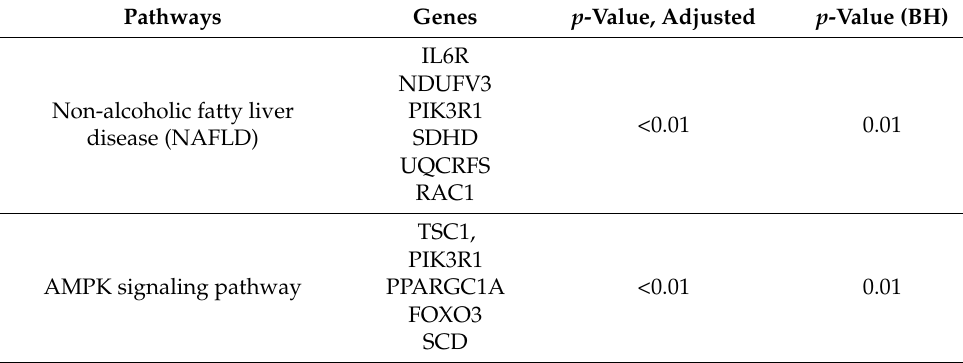
Figure 2. Evaluation of logistic regression models to compare Group 1 and Group 3. Table 6. Pathways regulated by miRNAs hsa-miR-451a, hsa-miR-23a-3p, hsa-miR-210-3p, hsa-miR-328- 3p, hsa-miR-425-3p. The target genes of the five identified miRNAs were extracted from the miRWalk database, and the intersection of identified target genes from GSEA tool programs was chosen. We correlated identified target genes with the KEGG (Kyoto Encyclopedia of Genes and Genomes) to point to biochemical pathways as potentially functional outputs of five deregulated